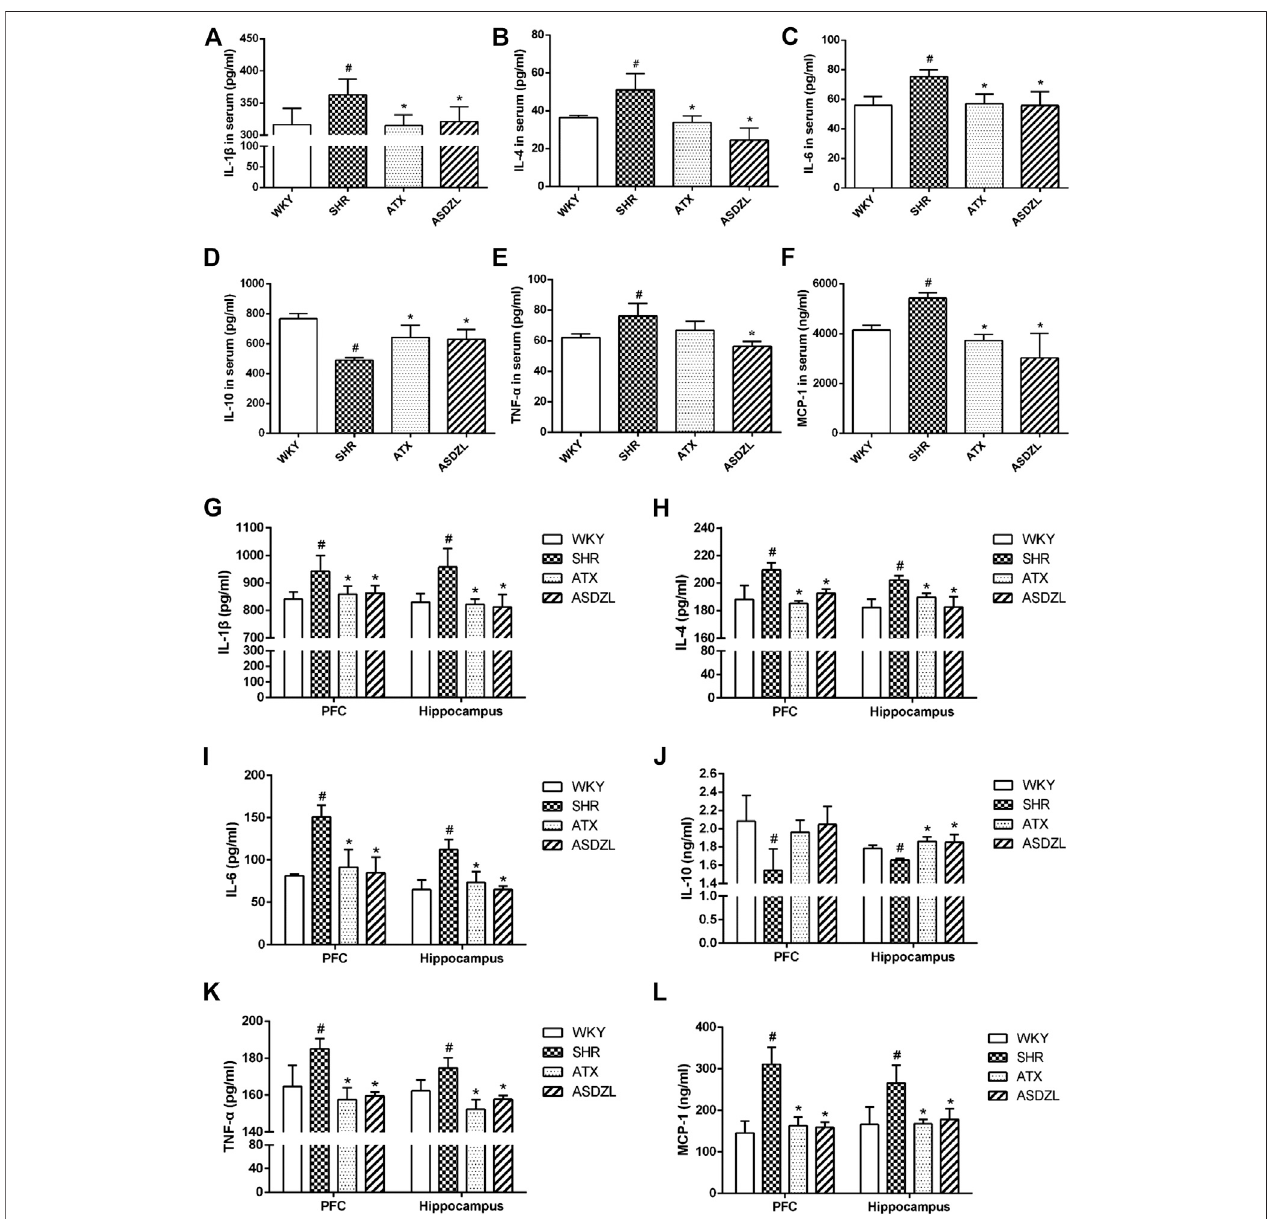
FIGURE3| EffectofASDZLonIL-1 β ,IL-4,IL-6,IL-10,TNF- α andMCP-1.(A – F)LevelsofIL-1 β ,IL-4,IL-6,IL-10,TNF- α andMCP-1intheserum.(G – L)LevelsofIL- 1 β , IL-4, IL-6, IL-10, TNF- α and MCP-1 in the PFC and hippocampus tissues. Data were presented as the mean ± SD, n (cid:2) four to six for each group. # p < 0.05 SHR vs. WKY group, *p < 0.05, compared to SHR group.